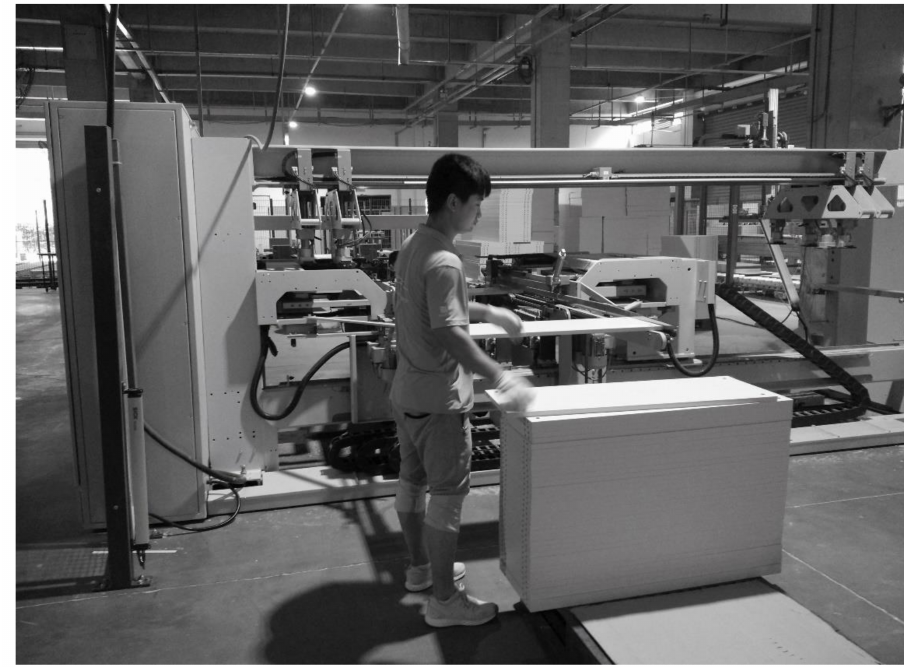
Figure 1. Handling panel boards to the inlet of six-row drilling machine (photo from a furniture manufacturing factory in